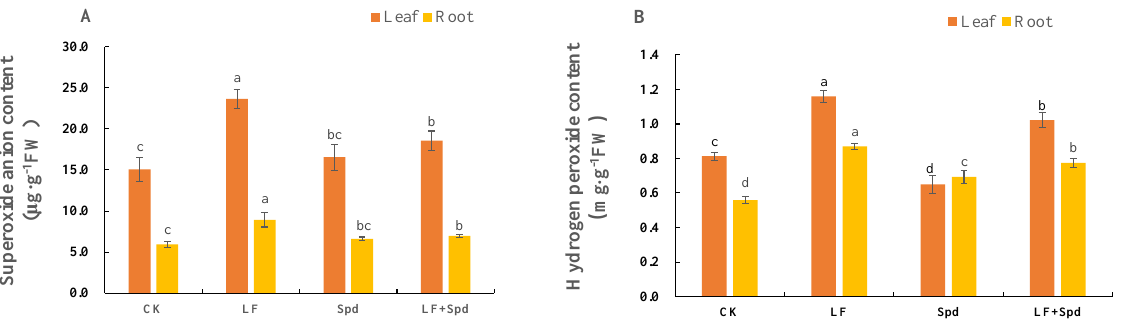
Figure 8. Effect of exogenous Spd on superoxide anion (O 2 • − ) content and hydrogen peroxide (H 2 O 2 ) content under low-iron stress in tomato plants ( A , B ). Means denoted by the different lower case letters are significantly different according to Duncan’s multiple range test ( p ≤ 0.05); the mean represents the average of three replicates and the vertical bar indicates ± standard deviation (SD).